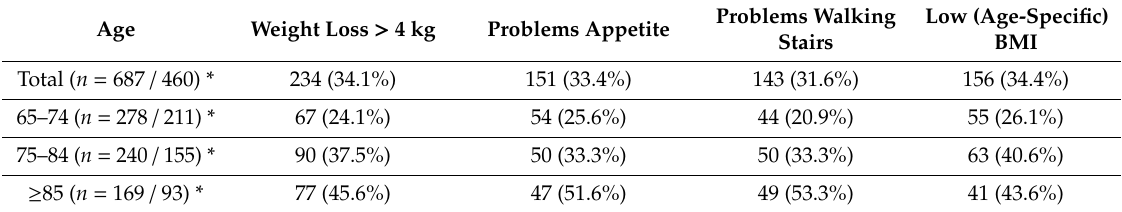
Table 4. Risk factors of adjusted SNAQ 65 + , compared by